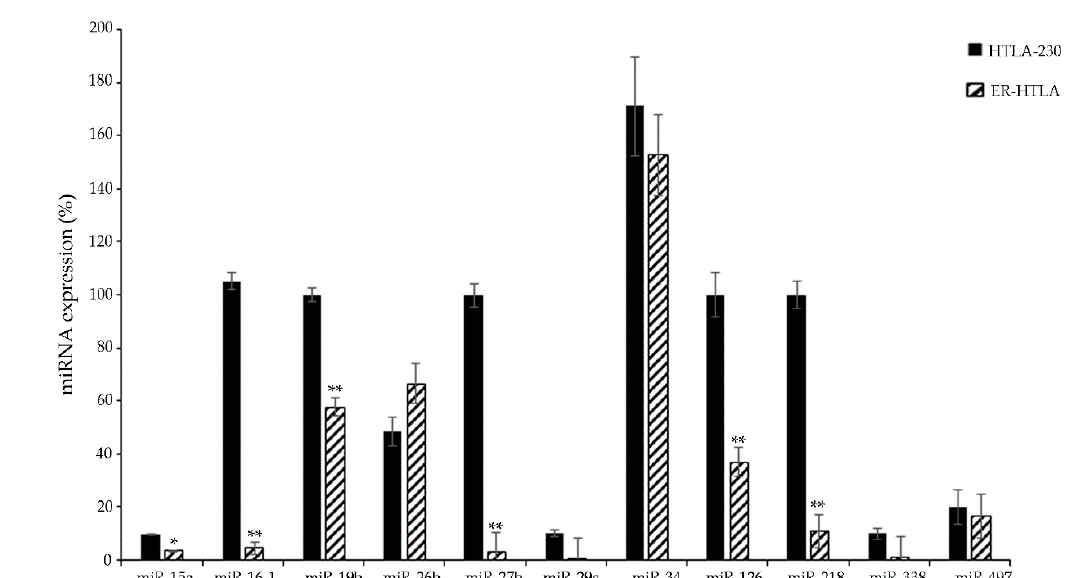
Figure 2. Evaluation of the expression level of the 11 selected miRNAs (Table 1) in HTLA-230 and ER-HTLA cell lines by RT-qPCR analysis. Data is reported as % variation vs. the universal small nuclear RNU38B. * p < 0.05 vs. HTLA-230 ** p < 0.01 vs. HTLA-230.